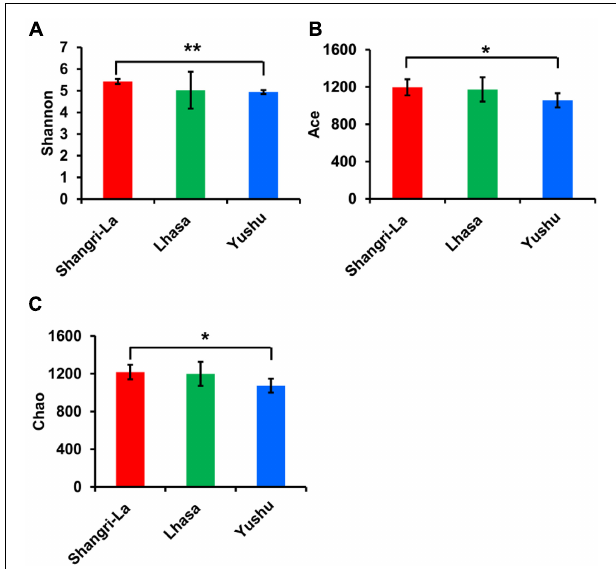
FIGURE 2 | Alpha diversity of gut bacteria among different places. (A) The Shannon index of each region. (B) The ACE index of each region. (C) The Chao index of each region. *indicates that differences between groups are significant, p < 0.05; **indicates that differences between groups are very significant, p <